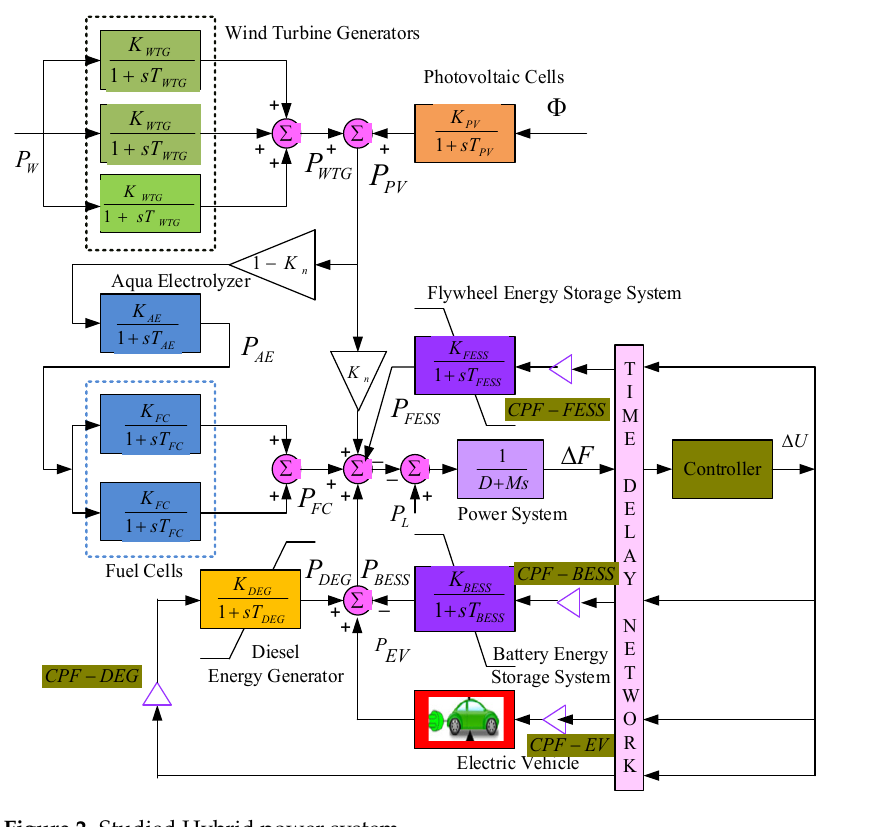
Figure 2. Studied Hybrid power system.